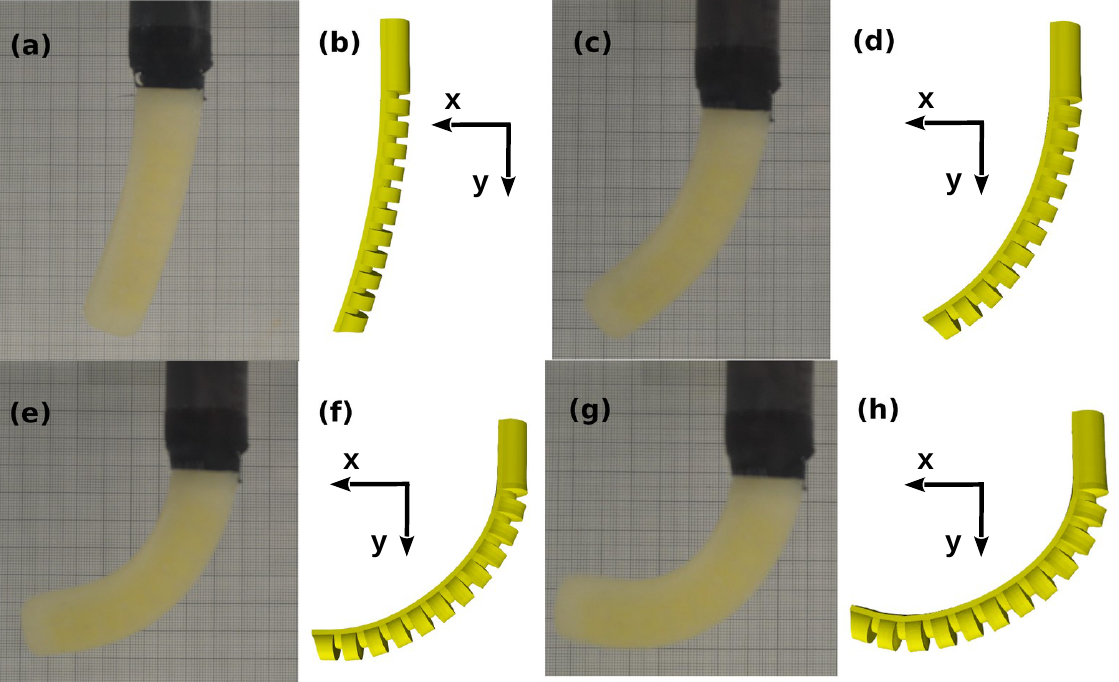
Figure 6. Displacement measurements of the soft actuator in underwater conditions and the resulting displacements of the non-linear finite element analysis applying an internal pressure of ( a , b ) 200 kPa, ( c , d ) 300 kPa, ( e , f ) 400 kPa, and ( g , h ) 500 kPa. Figure 7 shows the experimental trajectory of the endpoint of the soft actuator with different internal pressures measured with the photograms of the video. We use this infor- mation in the control of the grasping maneuver to consider the delays between the pressure increase and the actuation of the soft device.